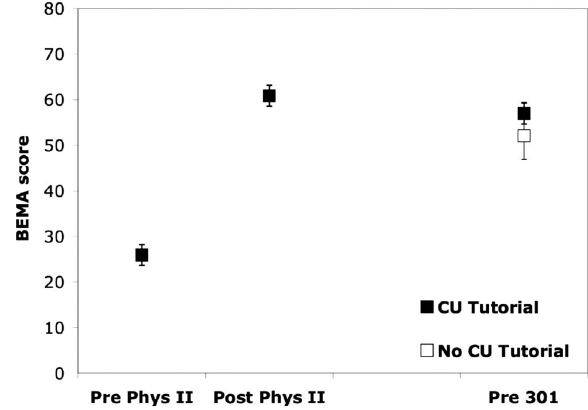
FIG. 5. Evolution of BEMA scores over time. This plot shows the trend of BEMA scores over time for two populations, those who had Tutorials in physics II (cid:1) N =38 (cid:2) , and those who bypassed physics II (cid:1) N =16 (cid:2) , and who took the BEMA as a pretest just at the start of Phys 301. (cid:1) Of course, we do not have Physics II data for the latter group.